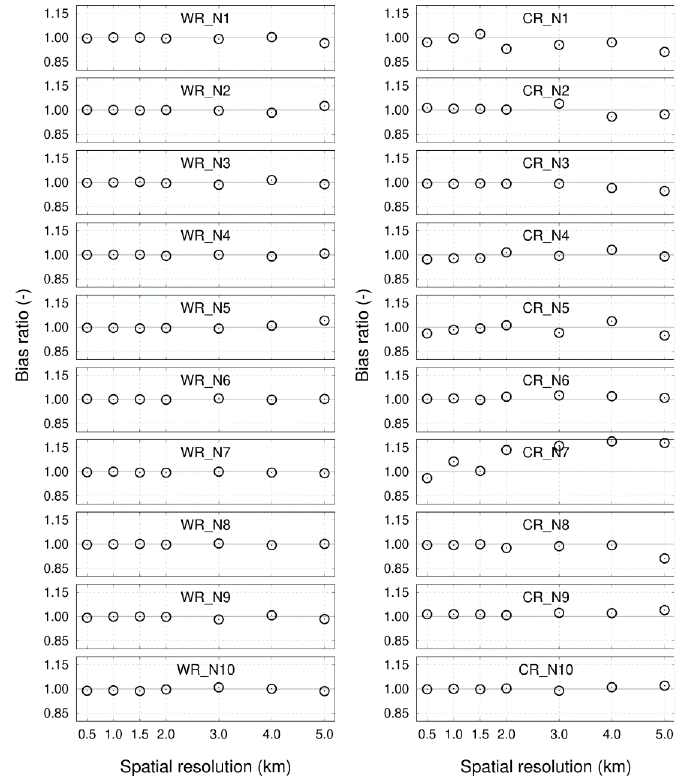
Figure 9. Total bias ratio of the basin-averaged accumulated rainfall for different spatial resolutions of all 20 rain events (left panel: widespread rain (WR) cases; right panel: convective rain (CR) cases).